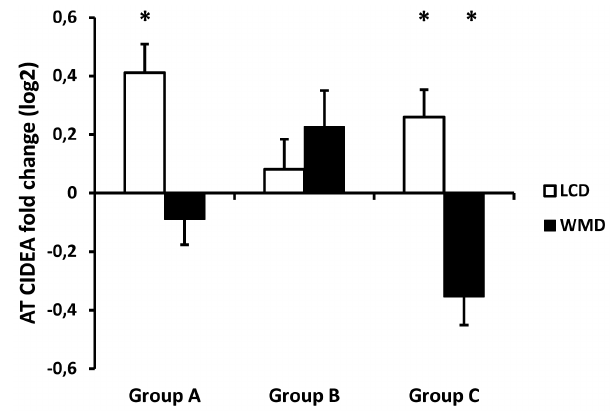
Figure 4. Adipose tissue CIDEA gene expression according to improvement of insulin sensitivity during dietary intervention (n=311). CIDEA mRNA levels fold change (FC) in subcutaneous adipose tissue were plotted according to FC in HOMA-IR during the entire dietary intervention. AT, adipose tissue; HOMA-IR, Homeostasis Model Assessment of Insulin Resistance. *: p , 0.05, difference between baseline and the end of dietary intervention. Values are means 6 SEM.